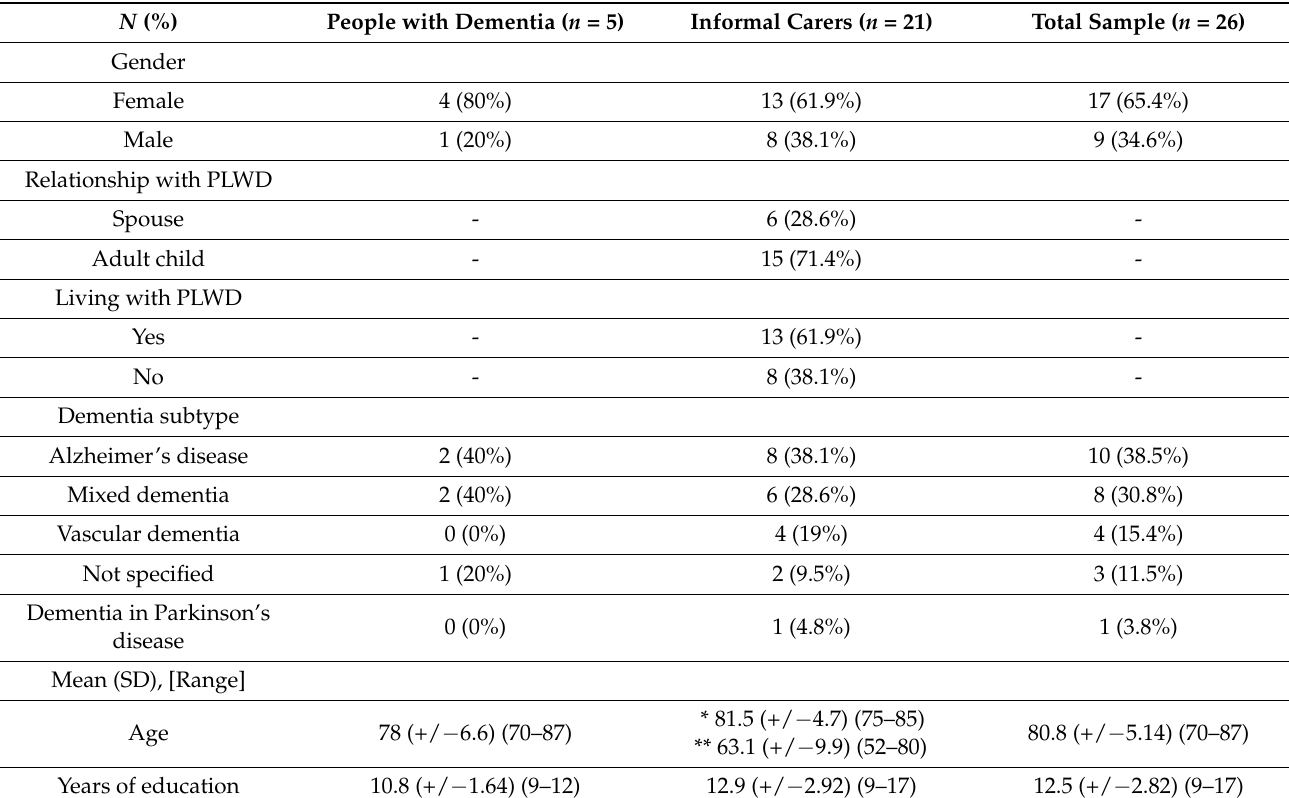
Table 1. Demographic characteristics of people with dementia and informal